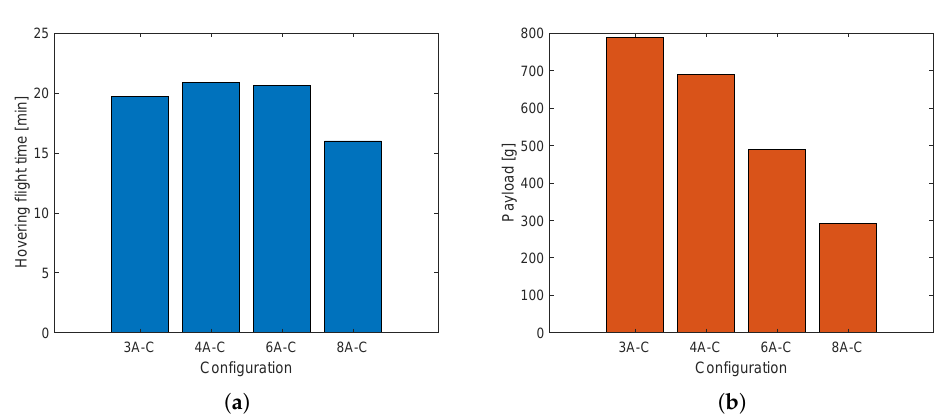
Figure 9. Hovering flight time ( a ) and payload ( b ) vs. the four different